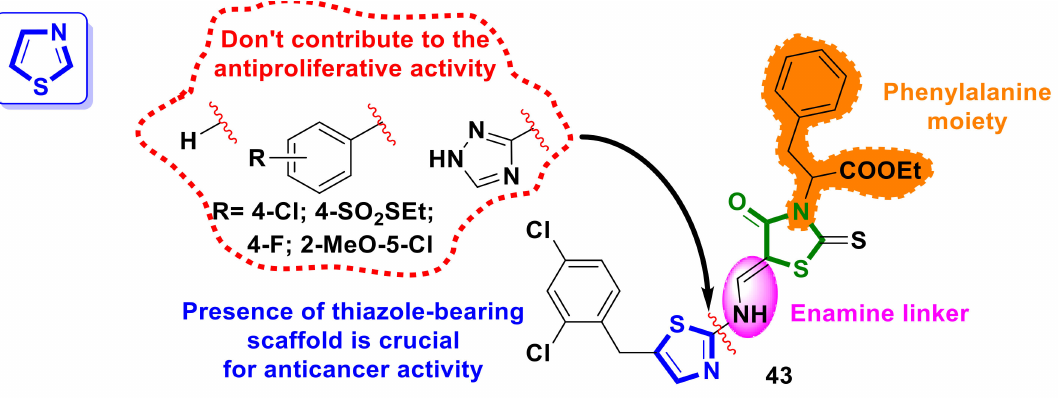
Figure 18. Structures of thiazole–4-thiazolidinone hybrids with antimitotic activity and SAR